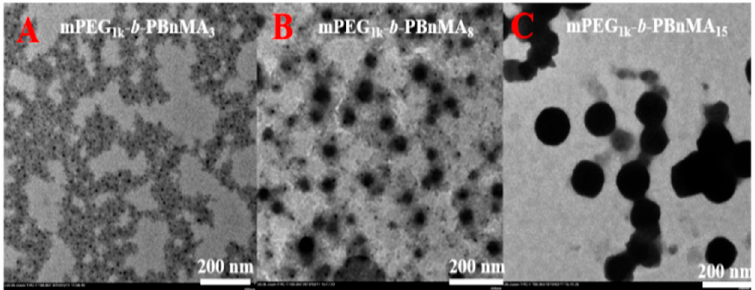
Figure 3. TEM images ( A – C ) of micelles from mPEG 1k - b -PBnMA x (x = 3, 8, and 15, respectively) via